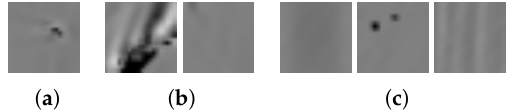
Figure 19. ( a ) One comet predicted as star crack by SVM + conv3 (CNN 20), ( b ) one comet and one grinding groove region predicted as star crack by SVM + 19 Features, ( c ) one comet, one grinding groove region, and one background region predicted as star crack by CNN